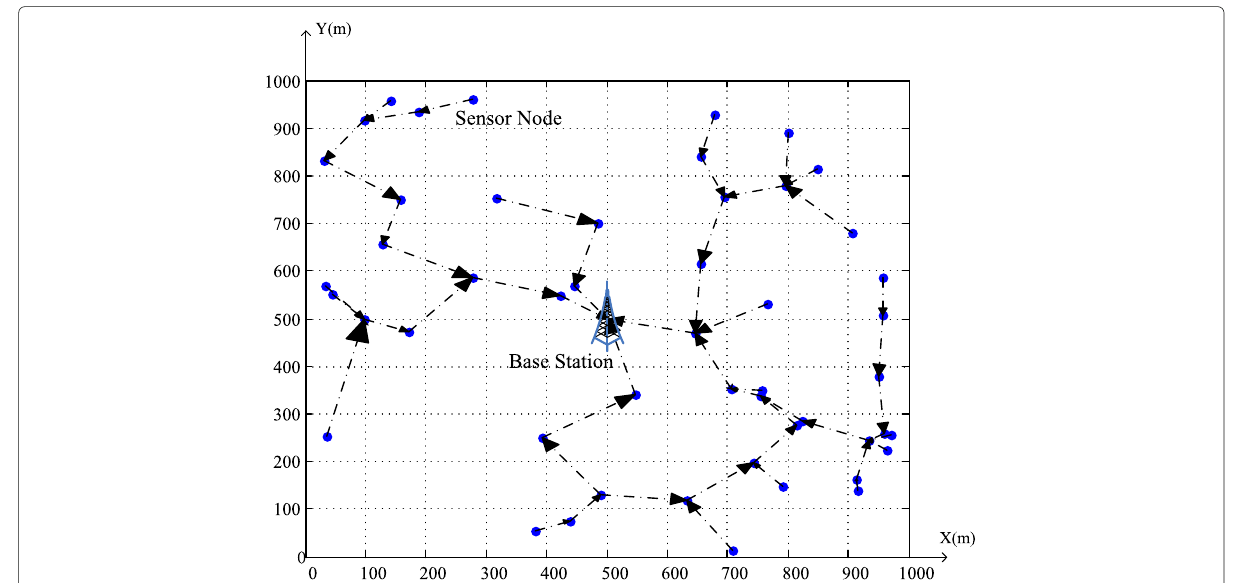
Fig. 4 The optimal traveling path of MCV during the 32th cycle. During the 32th cycle, the visiting set of MCV is F 32 = S 1 ∪ S 2 ∪ ... ∪ S 6 . Different from other schemes in previous researches, the MCV only needs to charge a portion of nodes during the 32th cycle. Based on previous analysis, the optimal traveling path is the shortest Hamiltonian cycle which connects all nodes in F 32 and the service